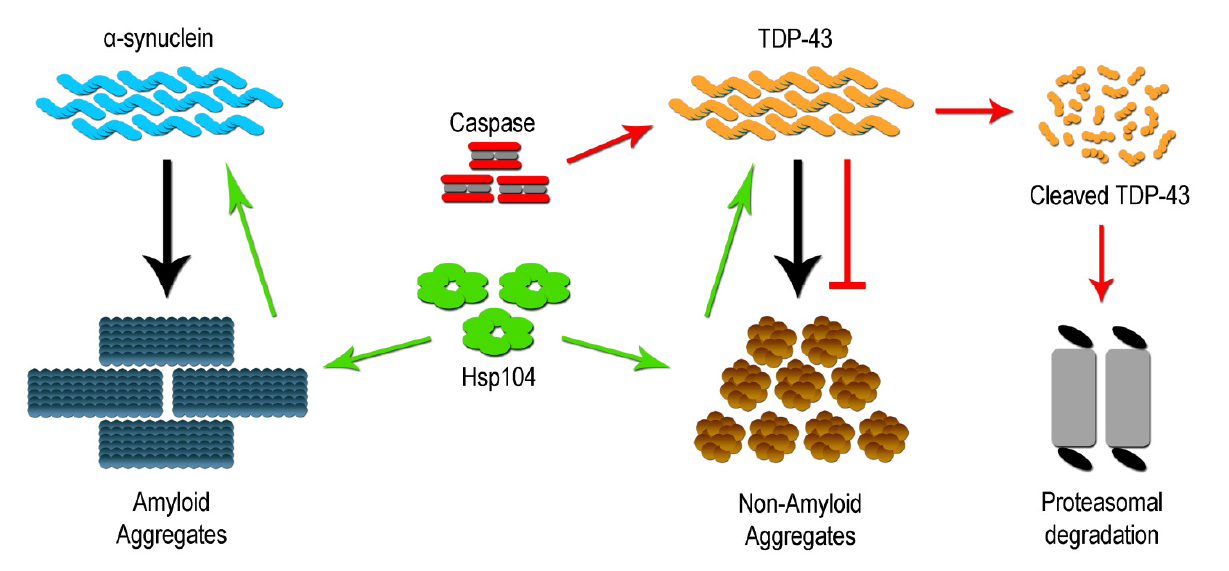
FIGURE 1: Therapeutic strategies to limit protein aggregation based disorders. Many neurodegeneration disorders are characterized by increased protein aggregation of diseased associated proteins like α-synuclein and TDP-43. The yeast specific disaggregase Hsp104 and its variants (green) have been shown to be an effective in limiting inclusion formation and accumulation. Hsp104 acts on the inclusion to dis- solve and restore them to the properly folded soluble form (TDP-43) as well as eliminate toxic soluble oligomeric forms (α-synuclein) of the protein. Additionally, caspase/metacaspase family of proteases (red) have also been shown to limit inclusion formation by directly cleaving the disease associated protein (TDP-43), which is subsequently degraded by the